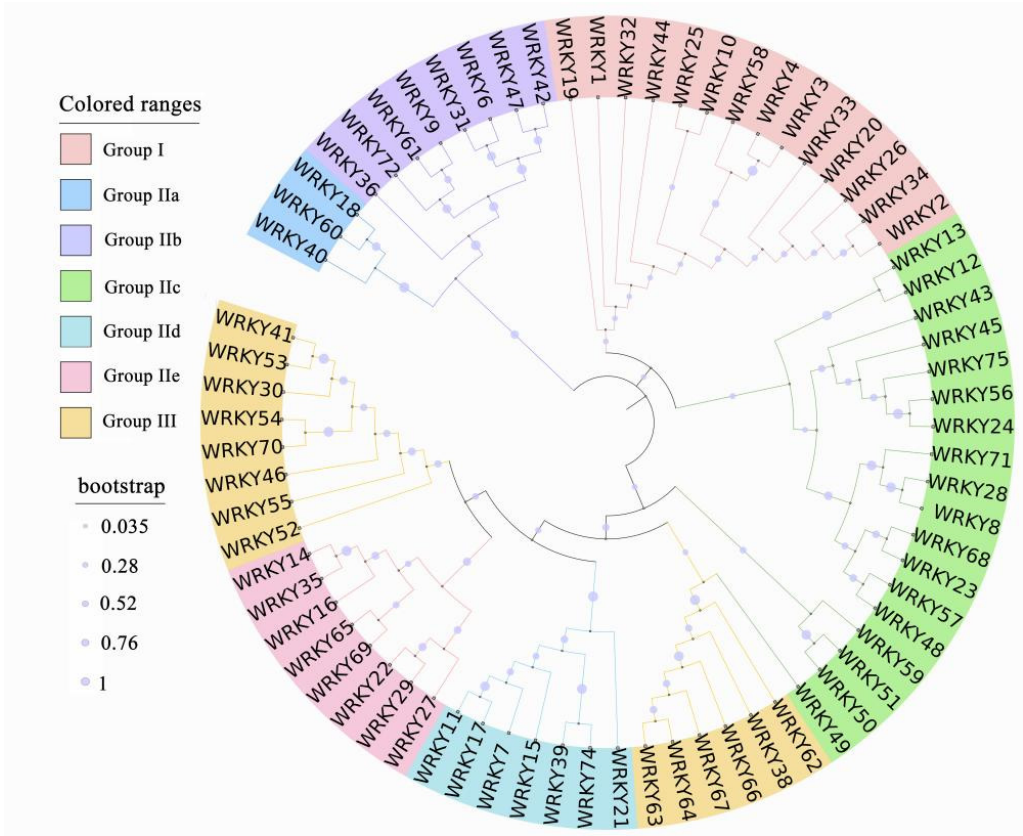
Figure 1. Phylogenetic tree of WRKY TFs from Arabidopsis . Through database searching, 72 ORFs encoding WRKY proteins were identified; MAGA7.0 software was used for multiple comparisons and the phylogenetic tree was generated with the iTOL program.